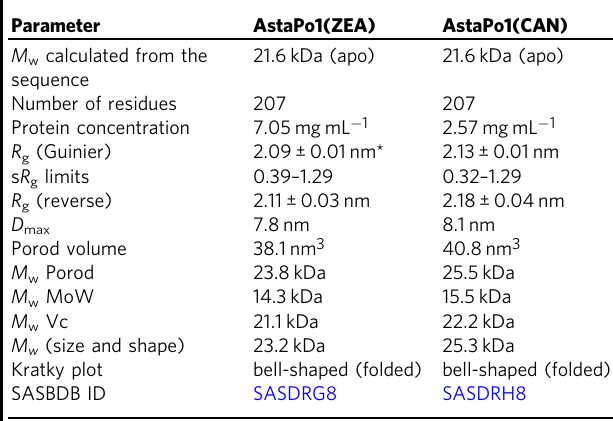
Table 2 SAXS-derived structural parameters of the two AstaPo1